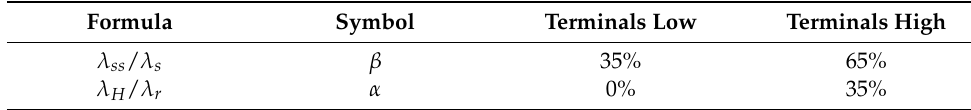
Table 5. The limits of variation the two